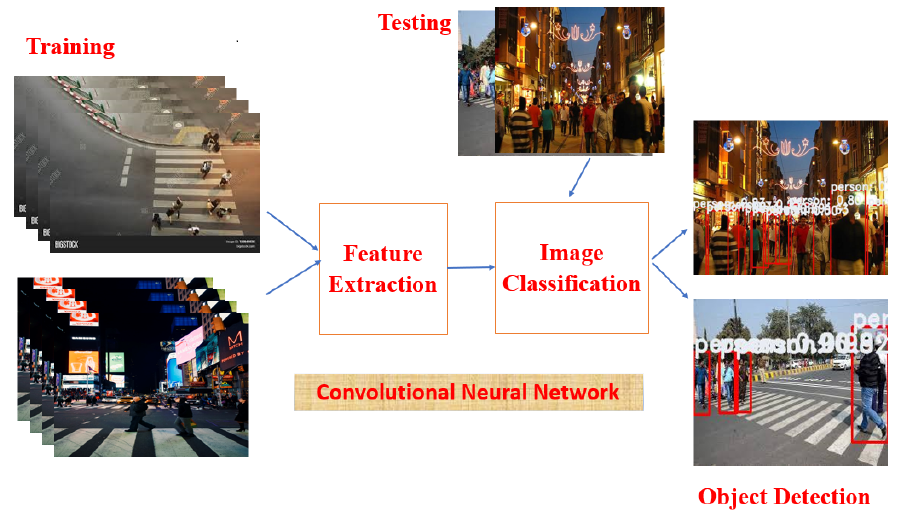
Figure 2. Basic block diagram of object detection.